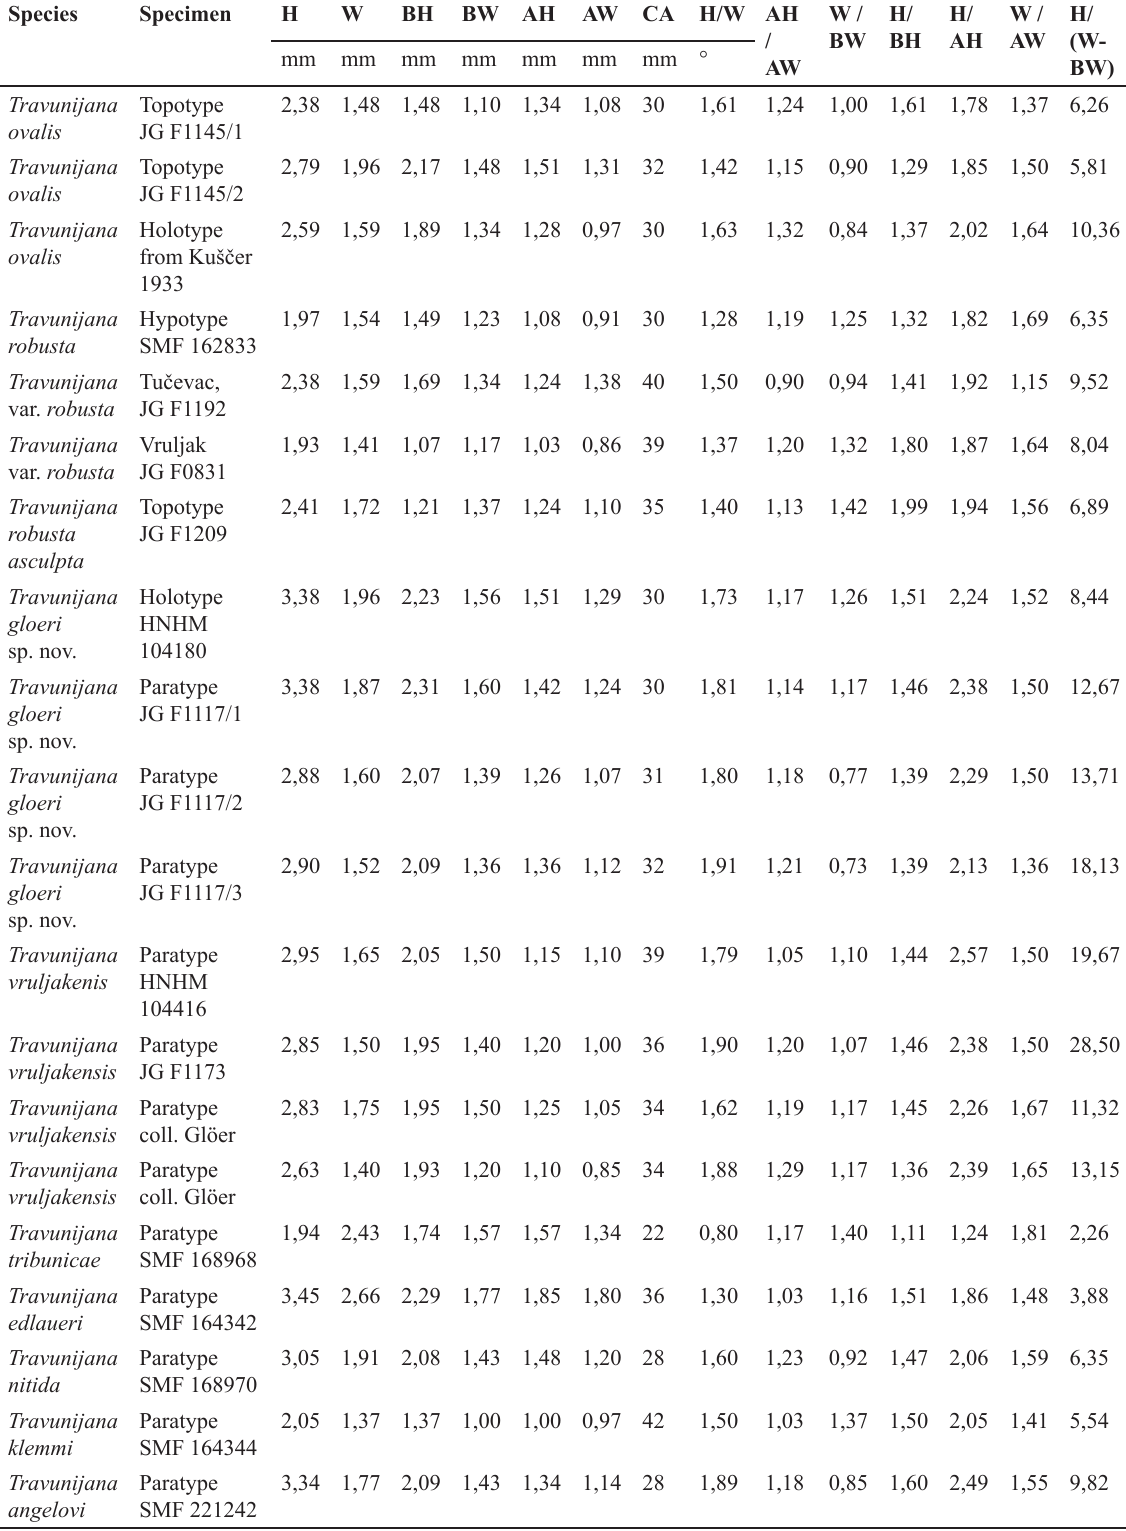
Table 4. Shell morphometry comparison of species of Travunijana Grego & Glöer,